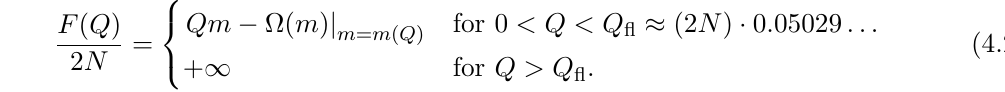
= m 0 . 9927 0 min r 0 ≈ (right). The fl ) ≈ min